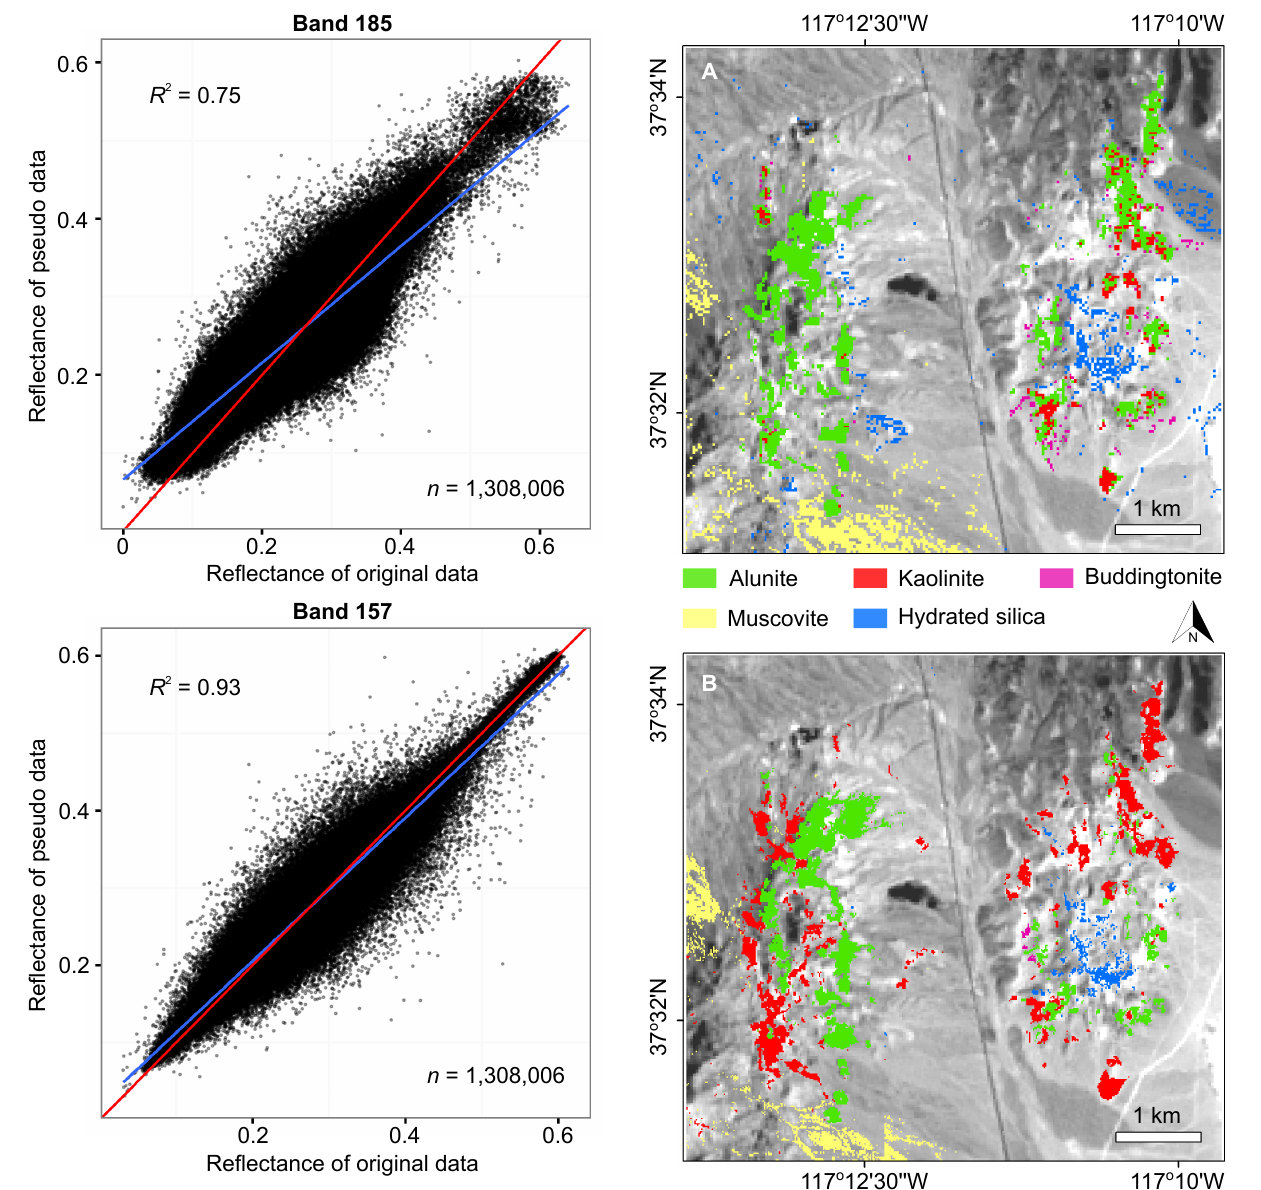
Figure 6: Mineral maps of spectrally dominant selected end- members for the pseudo-hyperspectral data (A) and AVIRIS